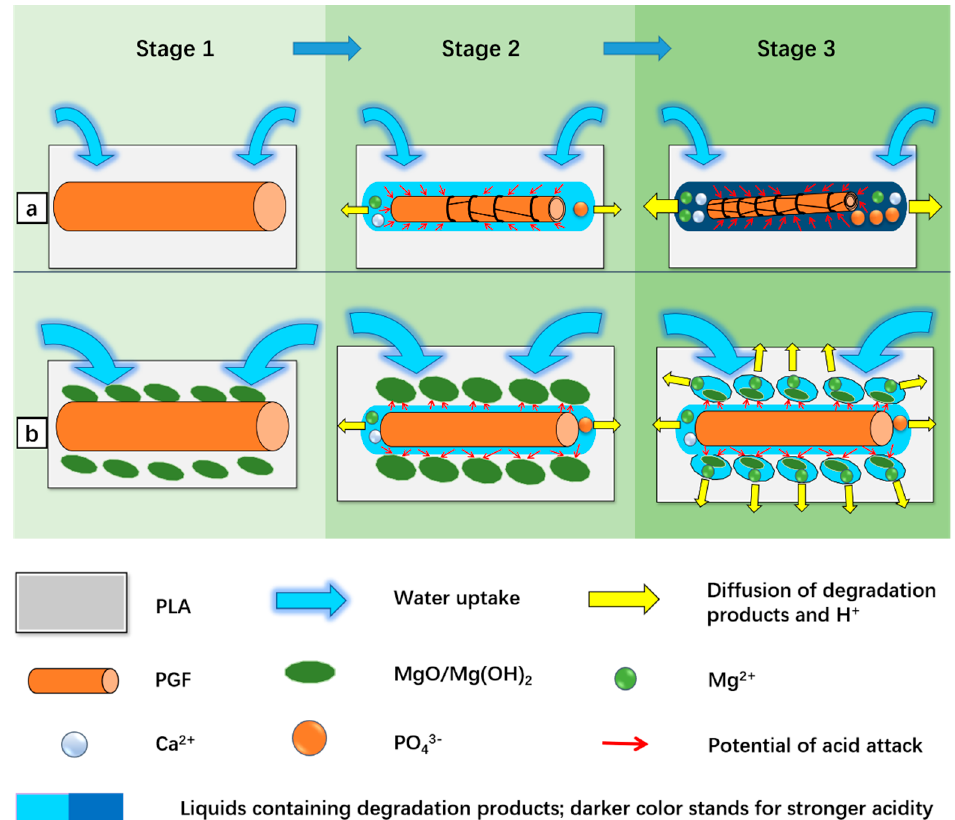
Figure 14. Schematic representation of the possible degradation mechanisms for different composites. ( a ) a mechanism for the binary PGF/PLA composite; ( b ) mechanism for the ternary (MgO + PGF/PLA) composite.